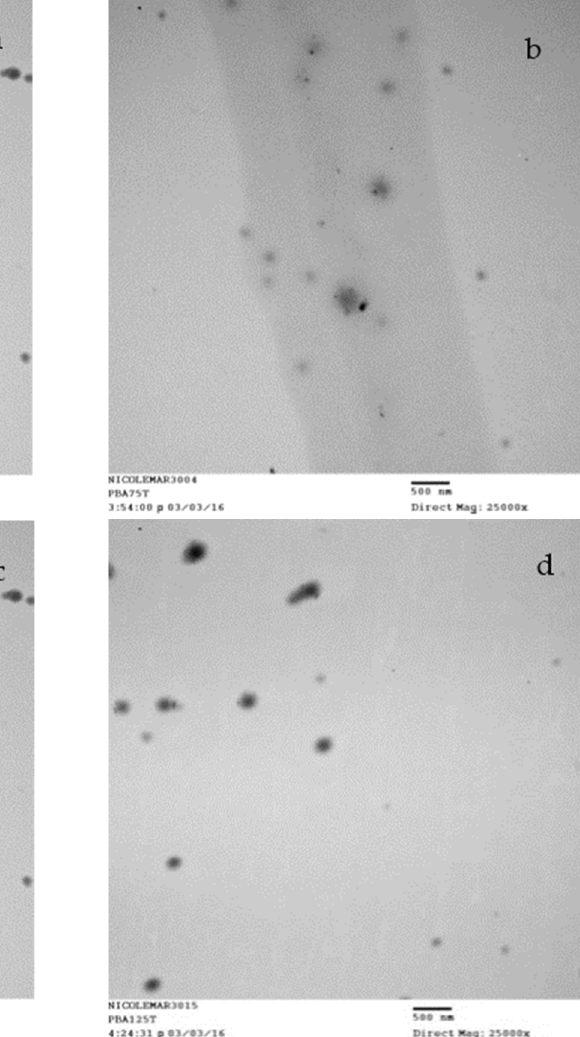
Figure 5. TEM images of samples after shaking incubation at 37 °C for 5 days. Samples shown are poly(HEMA, BAC, 3AAPBA) nanoparticles, sample C3 and C6 in Table 2, in the presence of water ( a , c ) and 10 mM DTT ( b , d ), respectively. For preparation, the samples were diluted and 5 × and 5 µ L was added to the TEM grid.